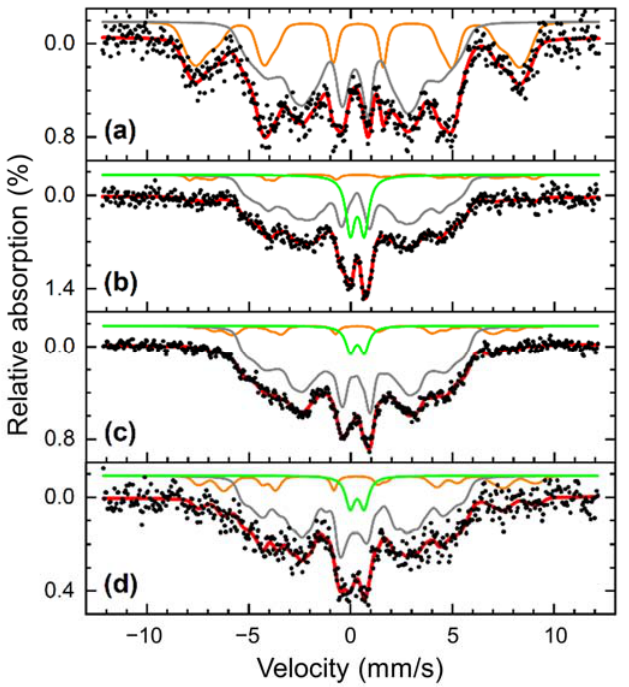
Figure 6. Mössbauer spectra of FeNi NP colloids: Prepared from dried acetone, aged for four months measured at 4.3 K ( a ) and 80 K ( b ), from dried acetone in the initial state at 80 K ( c ) and acetone in the initial state at 80 K ( d ). Spectra consist of an outer sextet distribution (orange) assigned to NiFe 2 O 4 , an inner sextet distribution corresponding to metallic FeNi (grey), and a doublet contribution (green) assigned to oxide material in the para ‐ or superparamagnetic state.